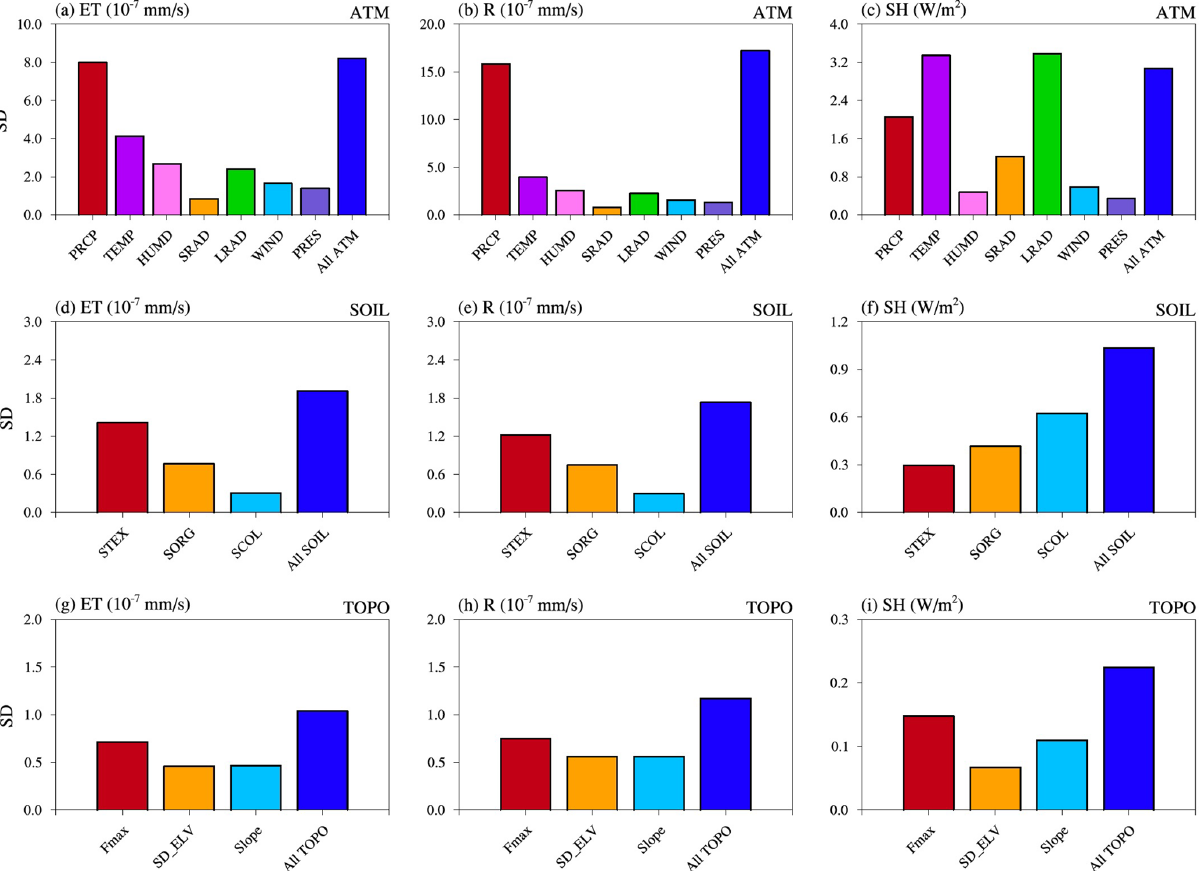
Figure 8. CONUS-averaged spatial variability for the annual climatological mean of ET (a, d, g) , R (b, e, h) , and SH (c, f, i) by each component and all components of ATM (a–c) , SOIL (d–f) , and TOPO (g–i)